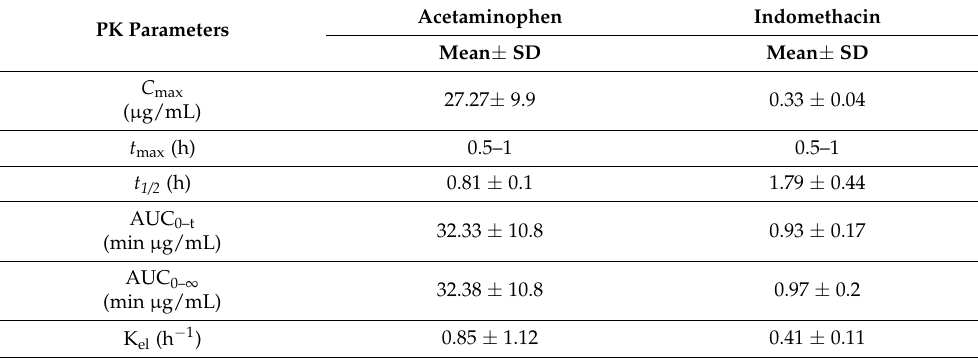
Figure 9. Pharmacokinetic profiles of ( A ) acetaminophen and ( B ) indomethacin. Table 4. Pharmacokinetic parameters to assess the extraction efficiency of 3D sorbent using acetaminophen and indomethacin.